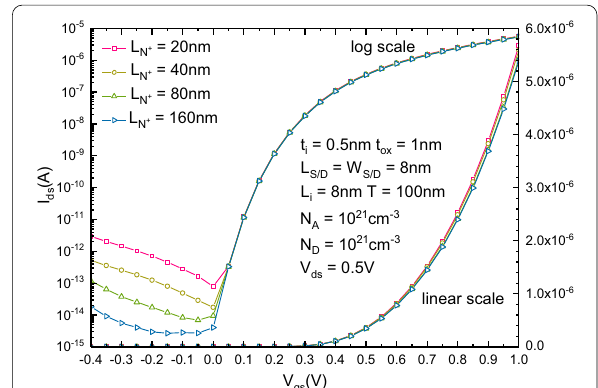
Fig. 6 I ds − V ds transfer characteristics of the optimized B‑TFET